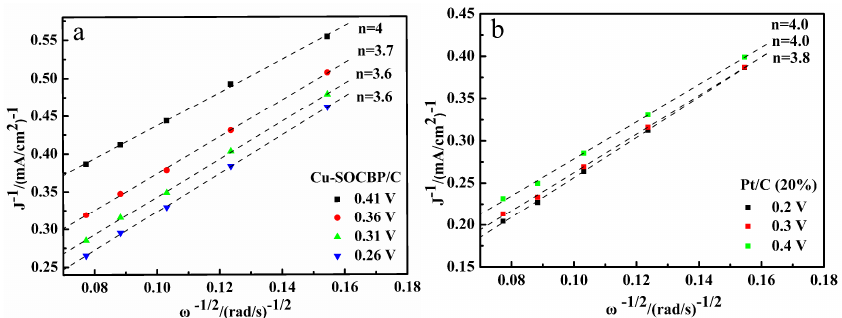
Figure 7. K-L plots at potentials of 0.41 V, 0.36 V, 0.31 V, and 0.26 V for Cu-SOCBP/C ( a ); and those for Pt/C at potentials of 0.2 V, 0.3 V, and 0.4 V ( b